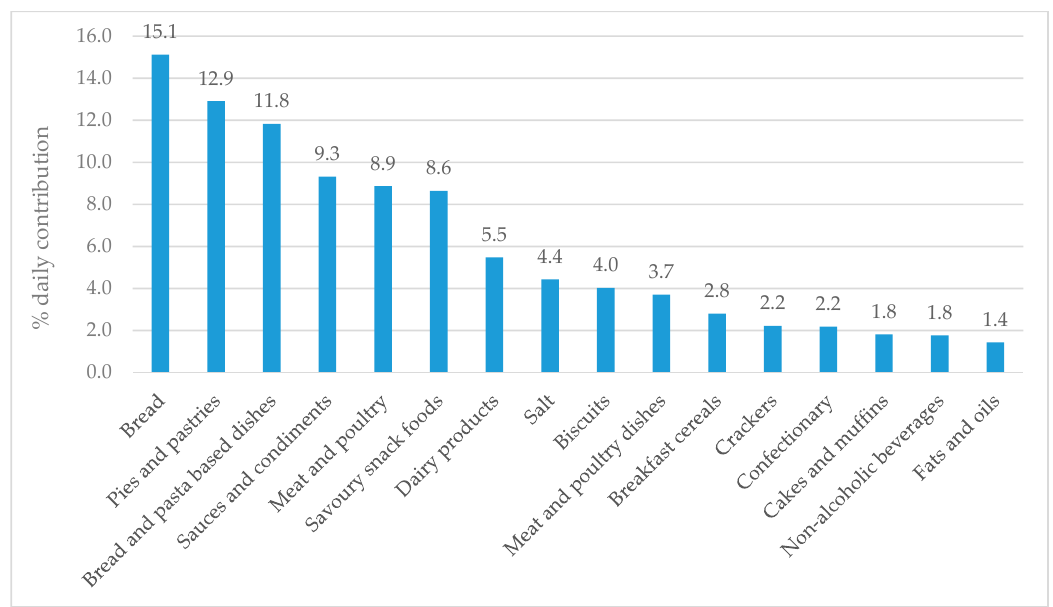
Figure 1. Daily contribution of sodium from 16 major food groups ( ≥ 1% daily contribution) among participating children ( n = 26).